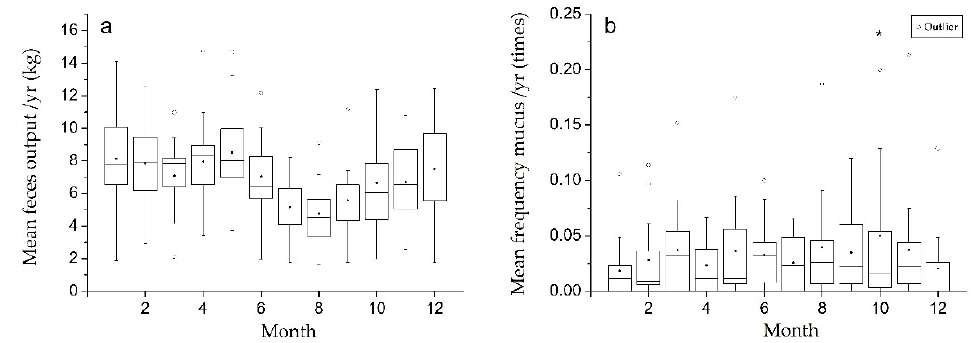
Figure 2. Average monthly changes in feces output ( a ) and mucus stool occurrence ( b ) for each month during the 15-year study. * indicates a significant peak.